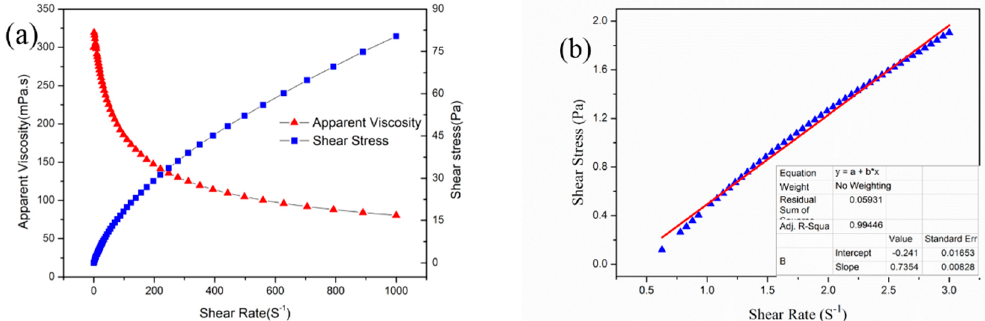
Figure 9. Shear resistance of PASD in NaCl solution: ( a ) effect of shear rate on apparent viscosity of sample; ( b ) effect of shear rate on shear stress in log–log scale.